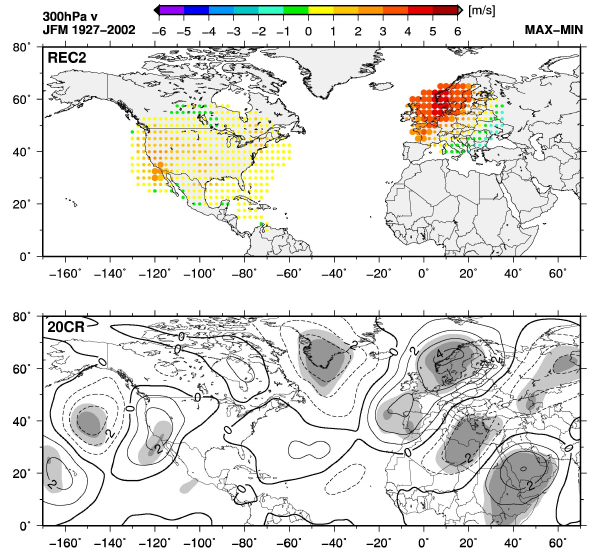
Fig. 8. Similar to Fig. 5, but showing meridional wind in ms − 1 .